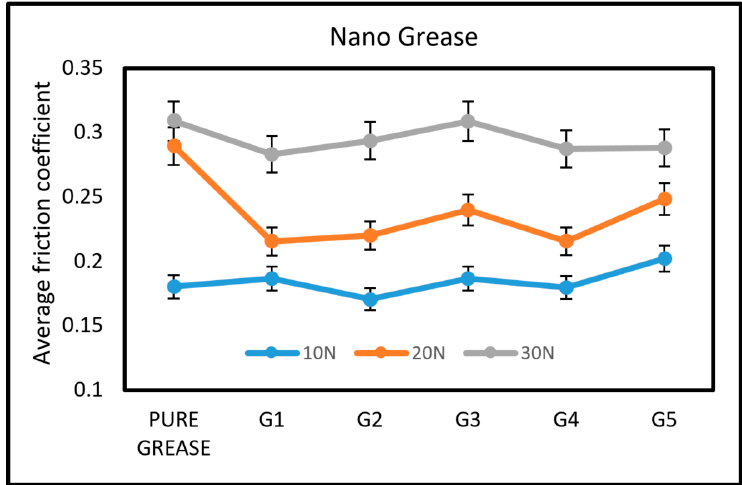
Figure 9. The average friction coefficient of nano additive grease at 10 N, 20 N, and 30 N normal load.